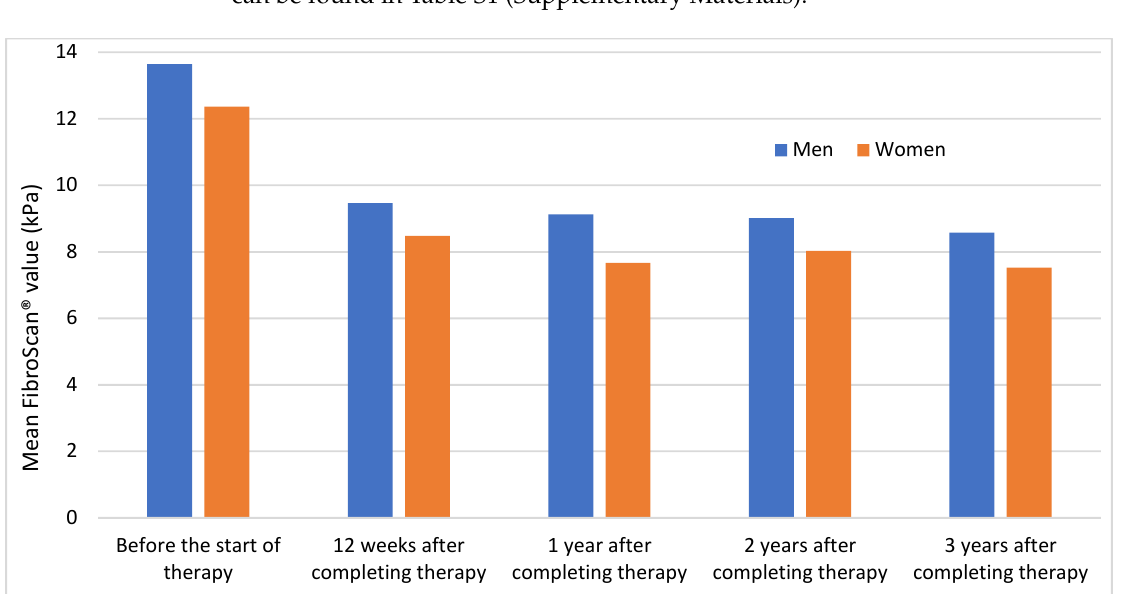
Figure 3. Trend of mean FibroScan ® values in men vs. women throughout the follow-up period.